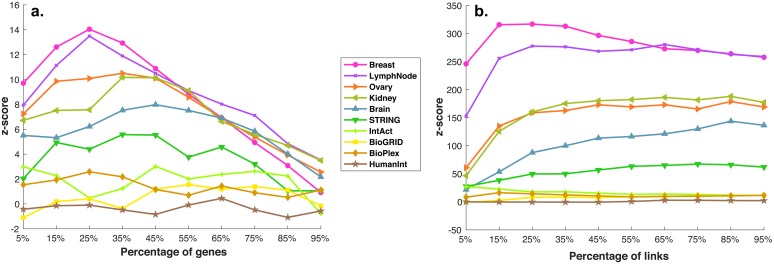
Similarity of existing biological networks to SyNet in terms of genes (a.) and links (b.).The x-axis represents the percentage of top gene/links used, the y-axis the z-score of observed vs. expected number of gene/links. The z-score is calculated by relating the observed number of SyNet gene/links that are present in existing biological networks to the expected distribution. To calculate the expected distribution, genes in biological networks are shuffled.